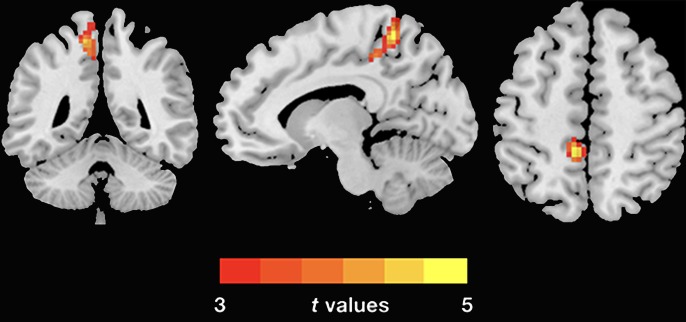
Group differences of dReHo variability were revealed by two-sample t-test. The PTSD group shows increased (warm color) dReHo variability in the left PCu (cluster size: 104; AAL: Precuneus_L; Brodmann area 7; MNI coordinates: X: −12 Y: −48 Z: 60; peak t-value = 5.1868) relative to the HC. The Gaussian random theory was used for cluster-level multiple comparison correction (minimum z > 3.54; cluster significance p < 0.05, GRF corrected). dReHo, dynamic regional homogeneity; PTSD, posttraumatic stress disorder; AAL, anatomical automatic labeling; PCu, precuneus; MNI, Montreal Neurological Institute.